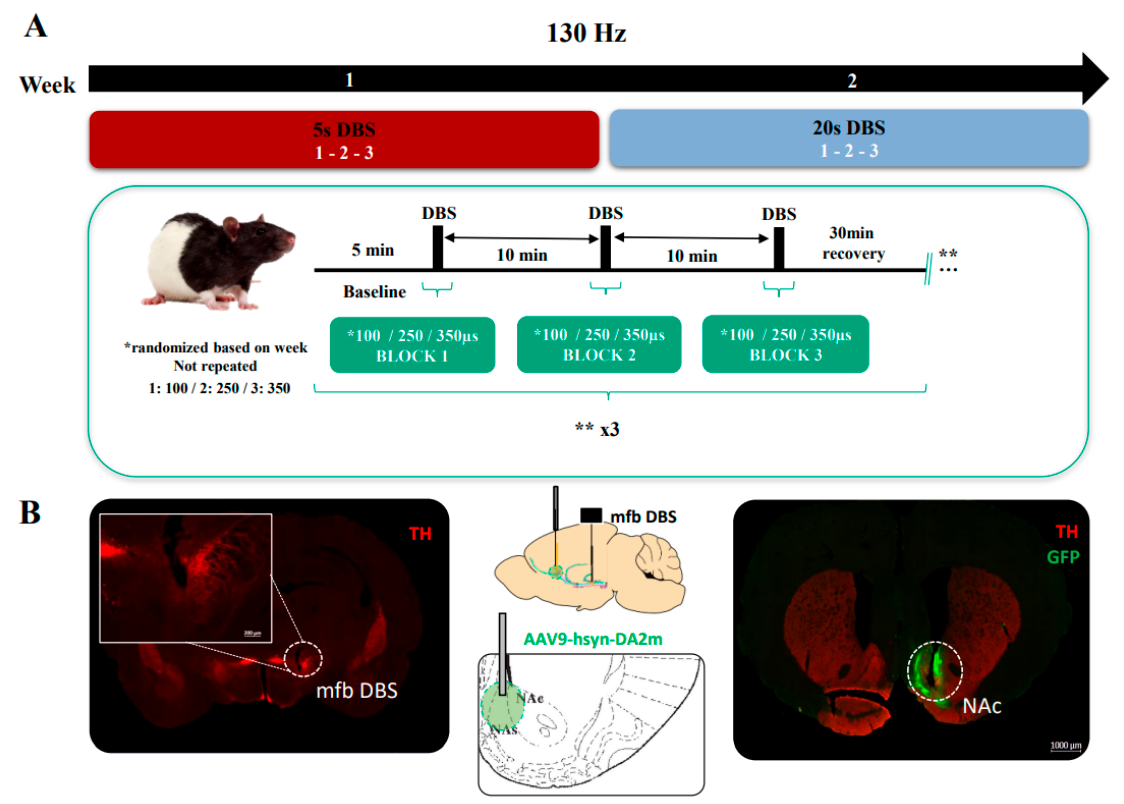
Figure 1. ( A ) Experimental design. Long–Evans rats received, per session, 5 min baseline recording followed by 5 s (week 1) or 20 s (week 2) 130 Hz DBS with a titrated mean amplitude of 200 µA, with 10 min inter-stimulation. The whole design was repeated 3 times for each different DBS parameter (100/250/300 µs PWs) with a 30 min wash-out period in between repetitions. ( B ) Schematics of the surgical target regions (middle images). Histological verification of the mfb DBS electrode (left image), optic fiber implantation and viral injection sites in the NAc (right image). Scale: 1000 µm. Magnified scale: 200 µm.